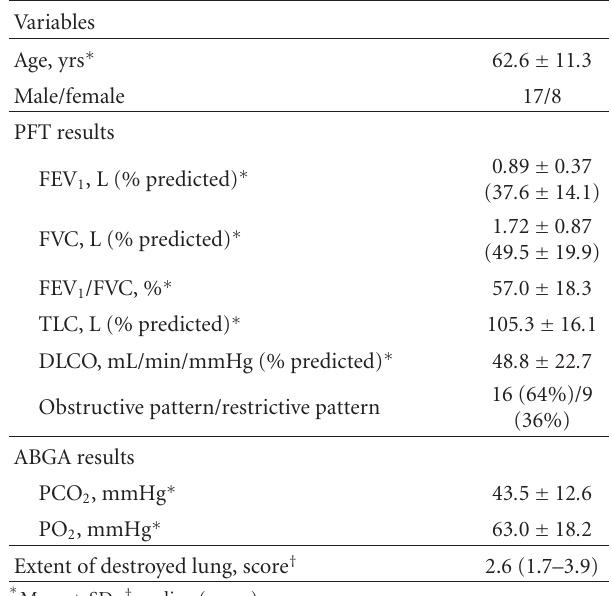
Table 1: Clinical characteristics ( n = 25). Table 2: Correlation of destroyed lung scores with pulmonary function (Spearman rank